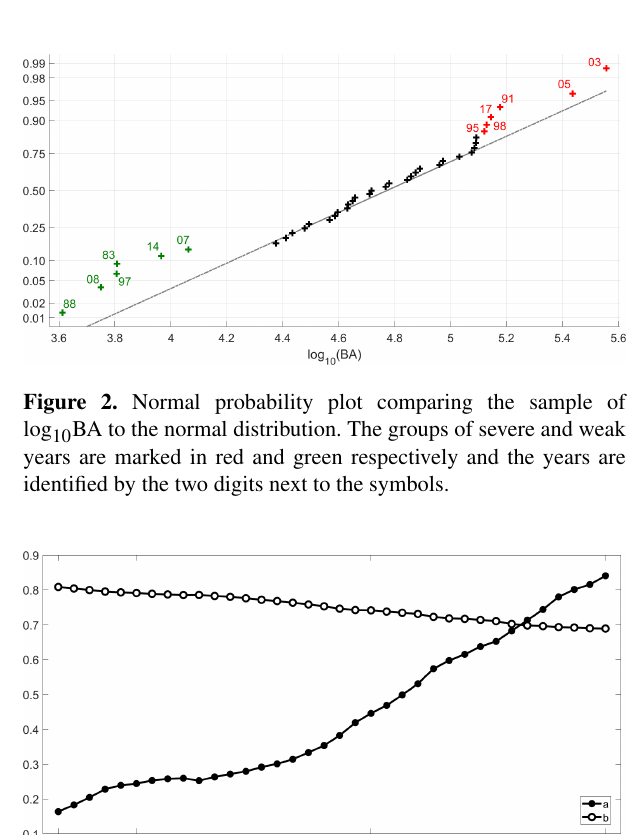
Figure 1. Time series of yearly cumulated BA (ha) in the fire season (July and August).